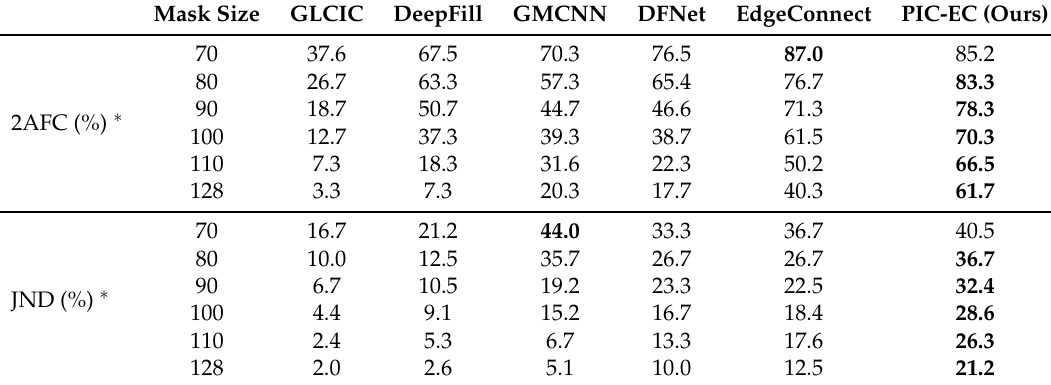
Table 6. User study results over the CelebA-HQ for six different squared masks with methods: GLCIC, DeepFill, GMCNN, DFNet, EdgeConnect and PIC-EC. Boldface in each row indicates the best performance. ∗ Higher is better.